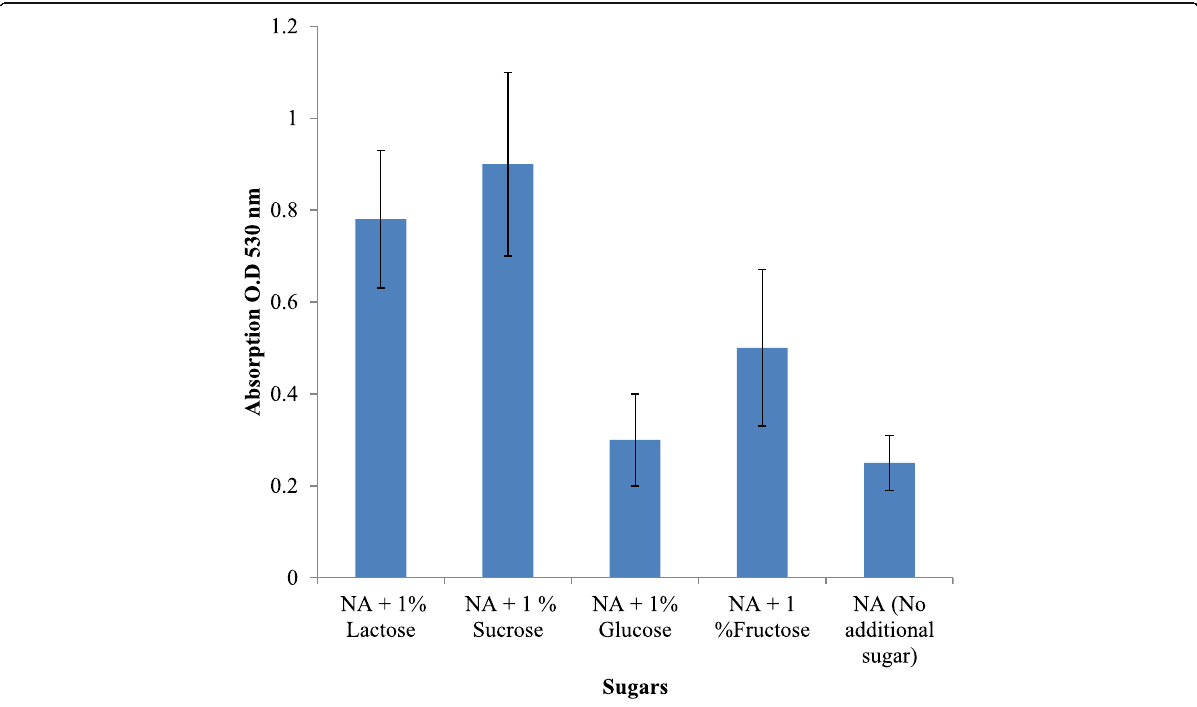
Fig. 4 Effect of carbon source on prodigiosin production